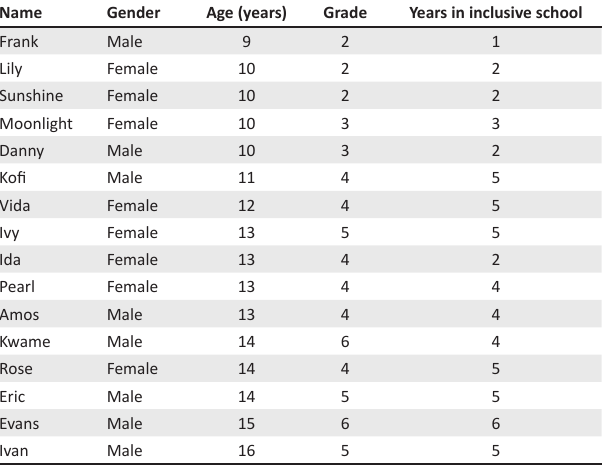
under desks, engage in fights with peers, look outside TABLE 2: Participant demographic information.